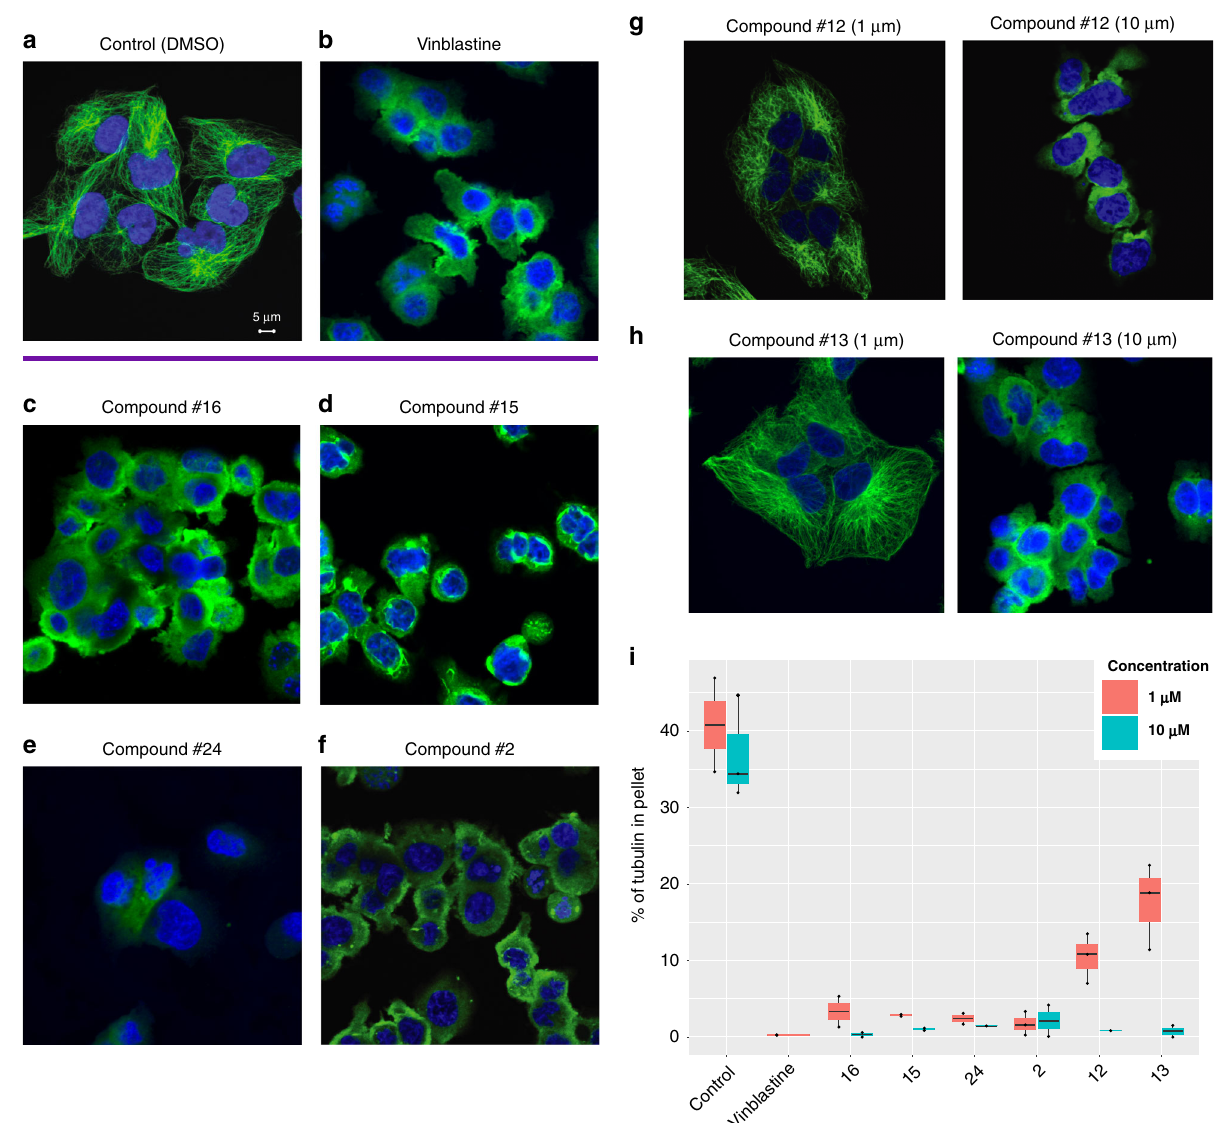
Fig. 3 Microtubules are a correct target of the newly identi fi ed small molecules. Effect of various compounds (1 μ M) on the microtubule integrity of MDA- MB-231 cells after 6 h of treatment. a Control with DMSO (Scale bar: 5 μ m), b Vinblastine as a positive control, c Compound #16, d Compound #15, e Compound #24 f Compound #2. g Dose dependent effect of Compound #12 and h Compound #13. i Box plot showing the % tubulin in the pellet compared to the supernatant for depolymerizing drugs at 1 and 10 μ M. The median is denoted by the center line and the min/max are represented by the whiskers. Each individual replicate is represented by a point in the box